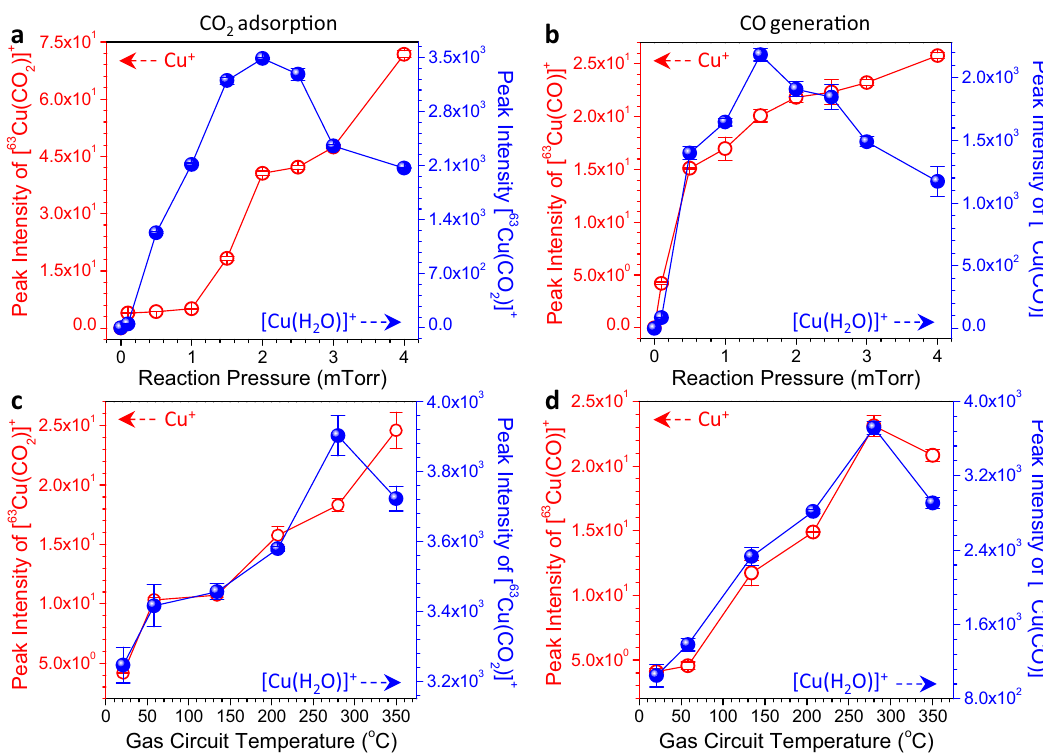
Fig. 3 Variation of CO 2 adsorption and CO generation with reaction pressure and temperature of heating tape around the gas circuit. Effect of reaction pressure on ( a ) the adsorption of CO 2 onto 63 Cu + and ( b ) CO generation by CO 2 reduction in the presence of either 63 Cu + or [ 63 Cu(H 2 O)] + catalysts (gas circuit temperature: 280 o C). Effect of the gas circuit temperature on ( c ) the adsorption of CO 2 onto Cu + and ( d ) CO generation by CO 2 reduction in the presence of either 63 Cu + or [ 63 Cu(H 2 O)] + catalysts (reaction pressure: 1.5